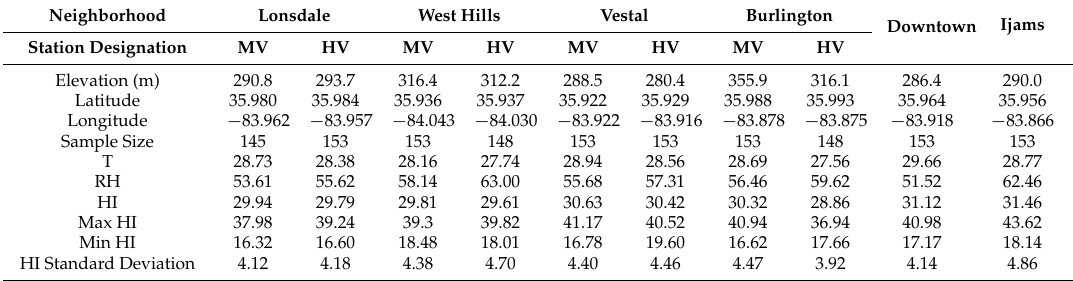
Table 2. Station information, including neighborhood name and station designation, elevation (m), location ( ˝ latitude and longitude), and sample size (number of days recorded). Also shown for